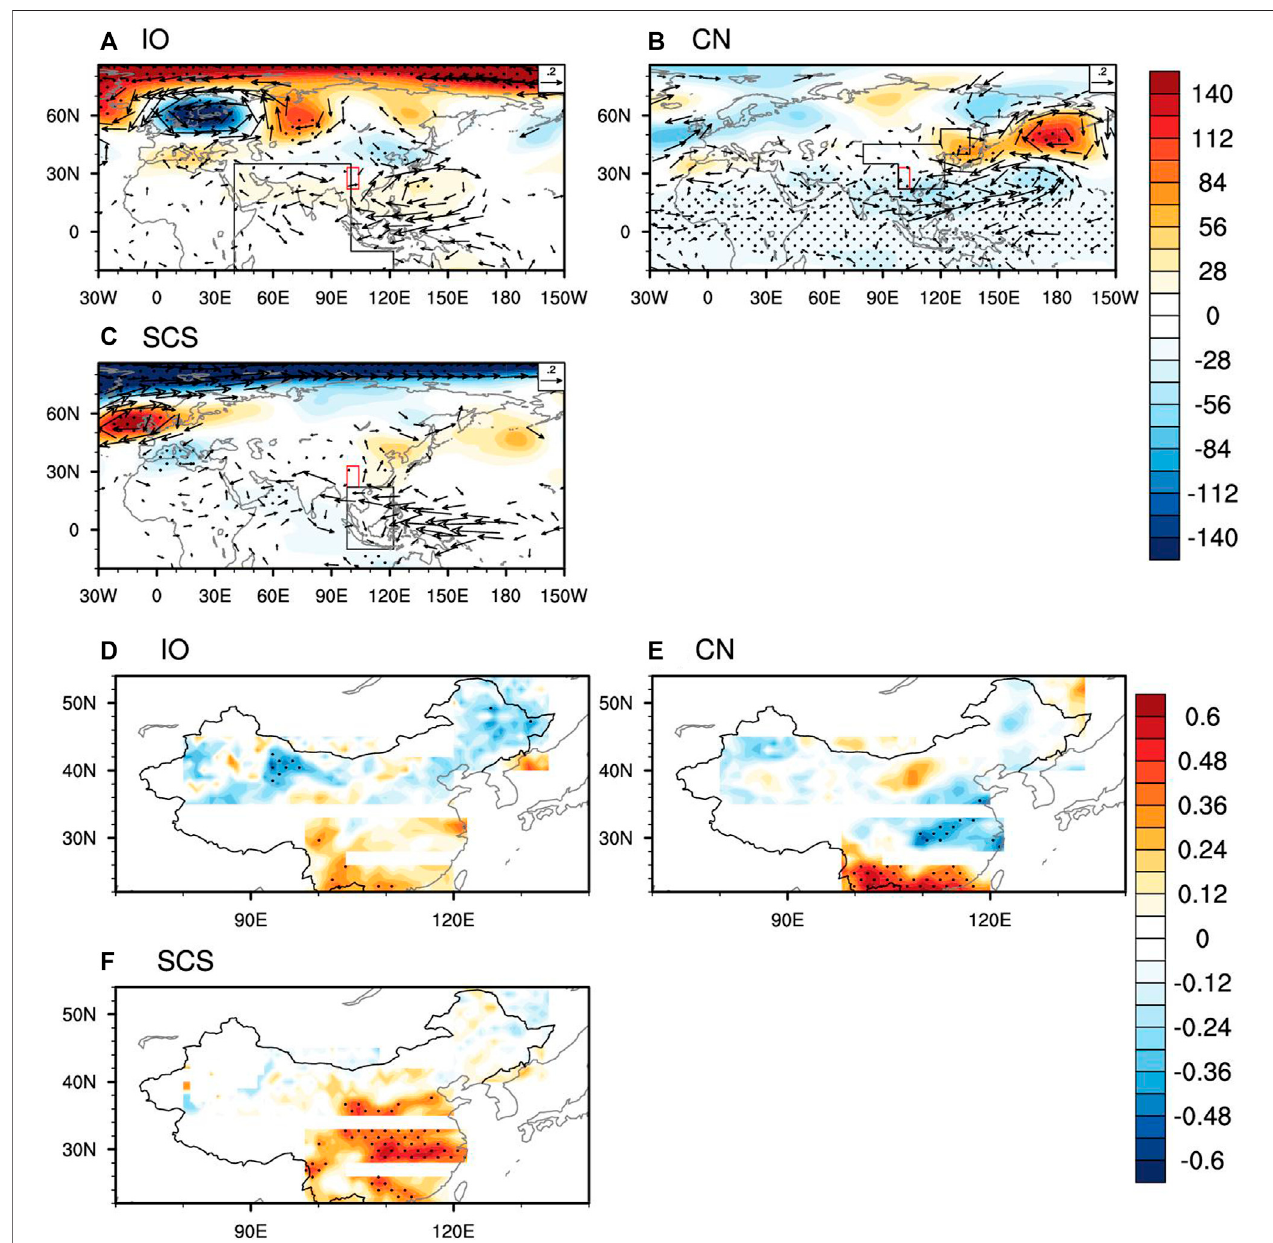
FIGURE 10 | As in Figure 5 but for Southwest China. Panels (A – C) show circulation anomalies regressed against the IO, CN and SCS moisture sources. Panels (D – F) show the IO source precipitation anomalies correlated with the reversed ISM index, the CN source with the reversed WNPSH index, and the SCS source with the WNPSH